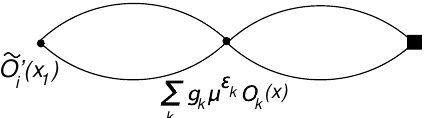
with a primary i